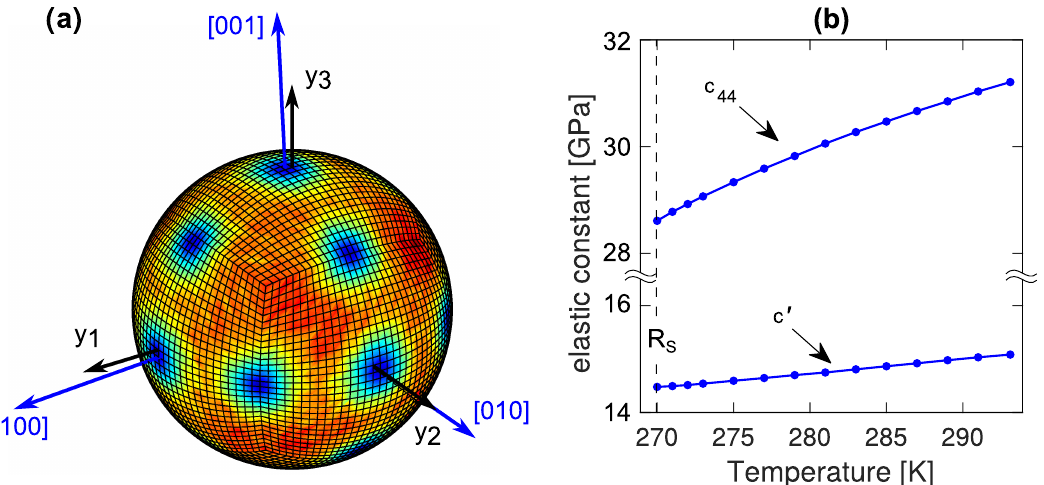
Figure 4. ( a ) the misorientation between the sample edges ( y 1,...,3 ) and the principal (cid:104) 100 (cid:105) directions. The map plotted on the unit sphere is a map of a function used for determination of the symmetry planes of the material for the measured 21 (triclinic) elastic constants, as introduced in [21]. In particular, the sharp minima (blue spots) correspond to directions perpendicular to the mirror planes. ( b ) the resulting evolution of the elastic